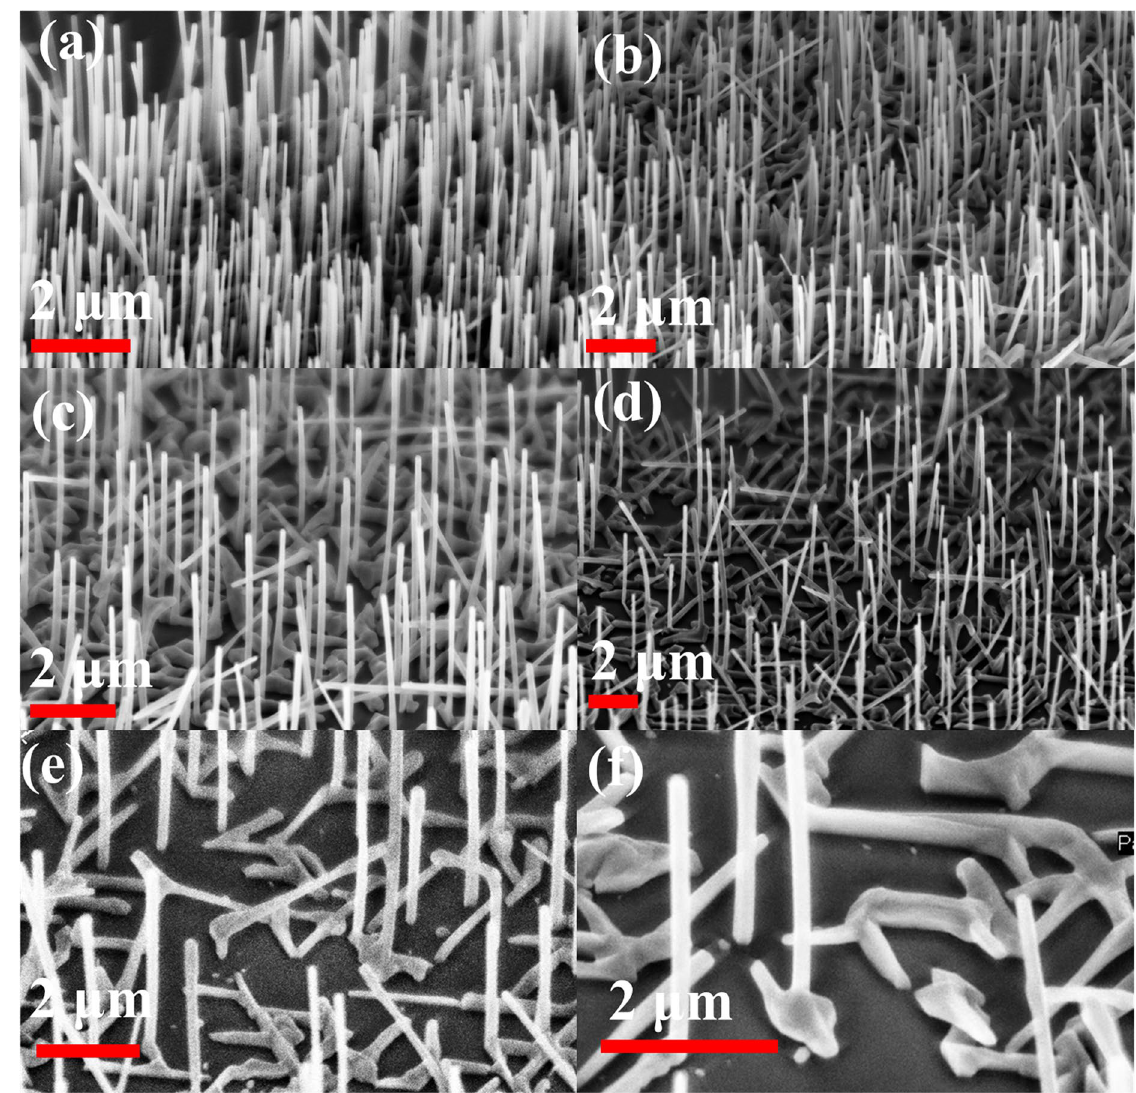
Figure 1. SEM images for GaAsSbN sample A for pitch lengths of ( a – f ) 200, 400, 600, 800, 1000, and 1200